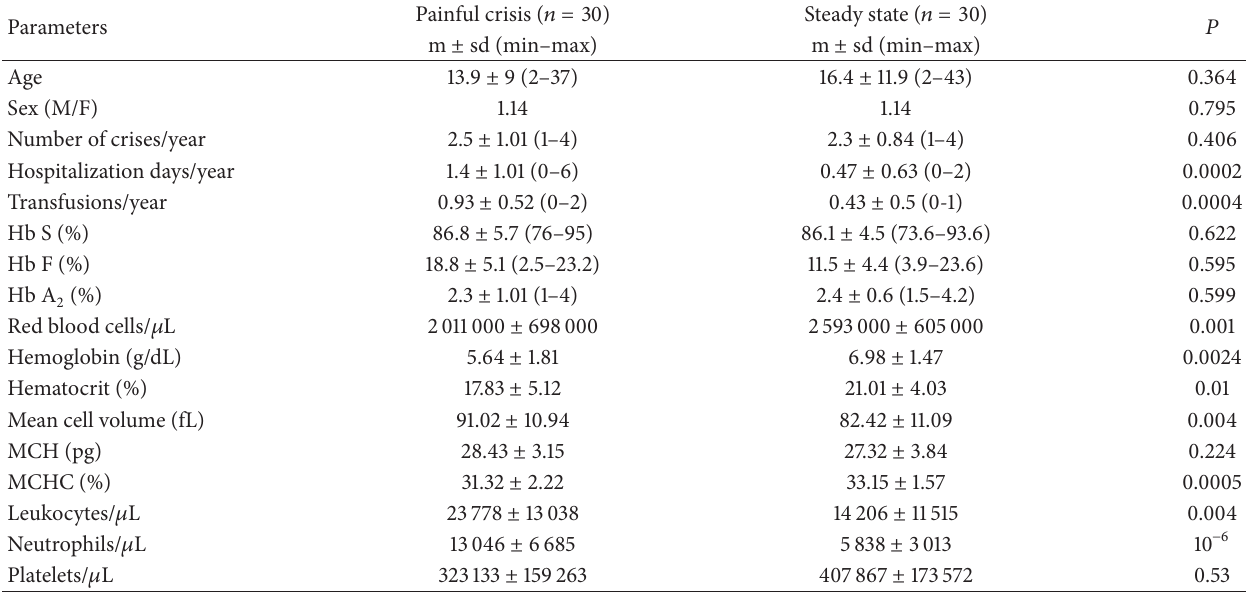
Table 1: Influence of clinical status on epidemiological, clinical, and biological parameters. Parameters